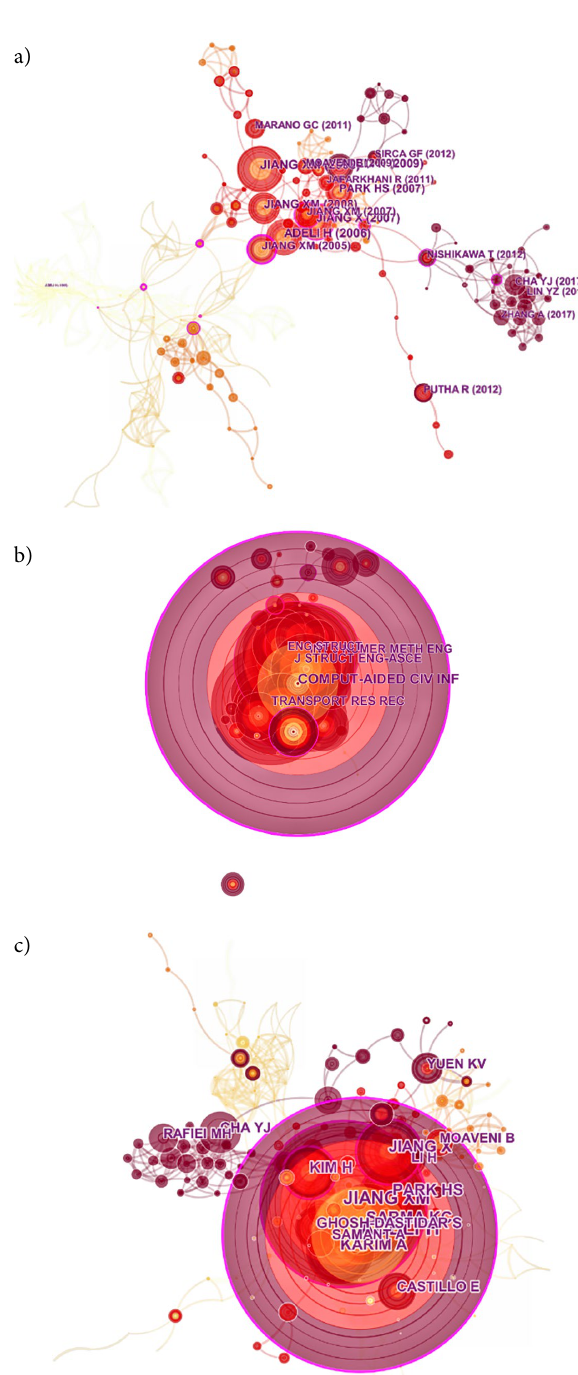
Figure 4. The cited references/sources/authors networks of publications in the journal: a – the cited references